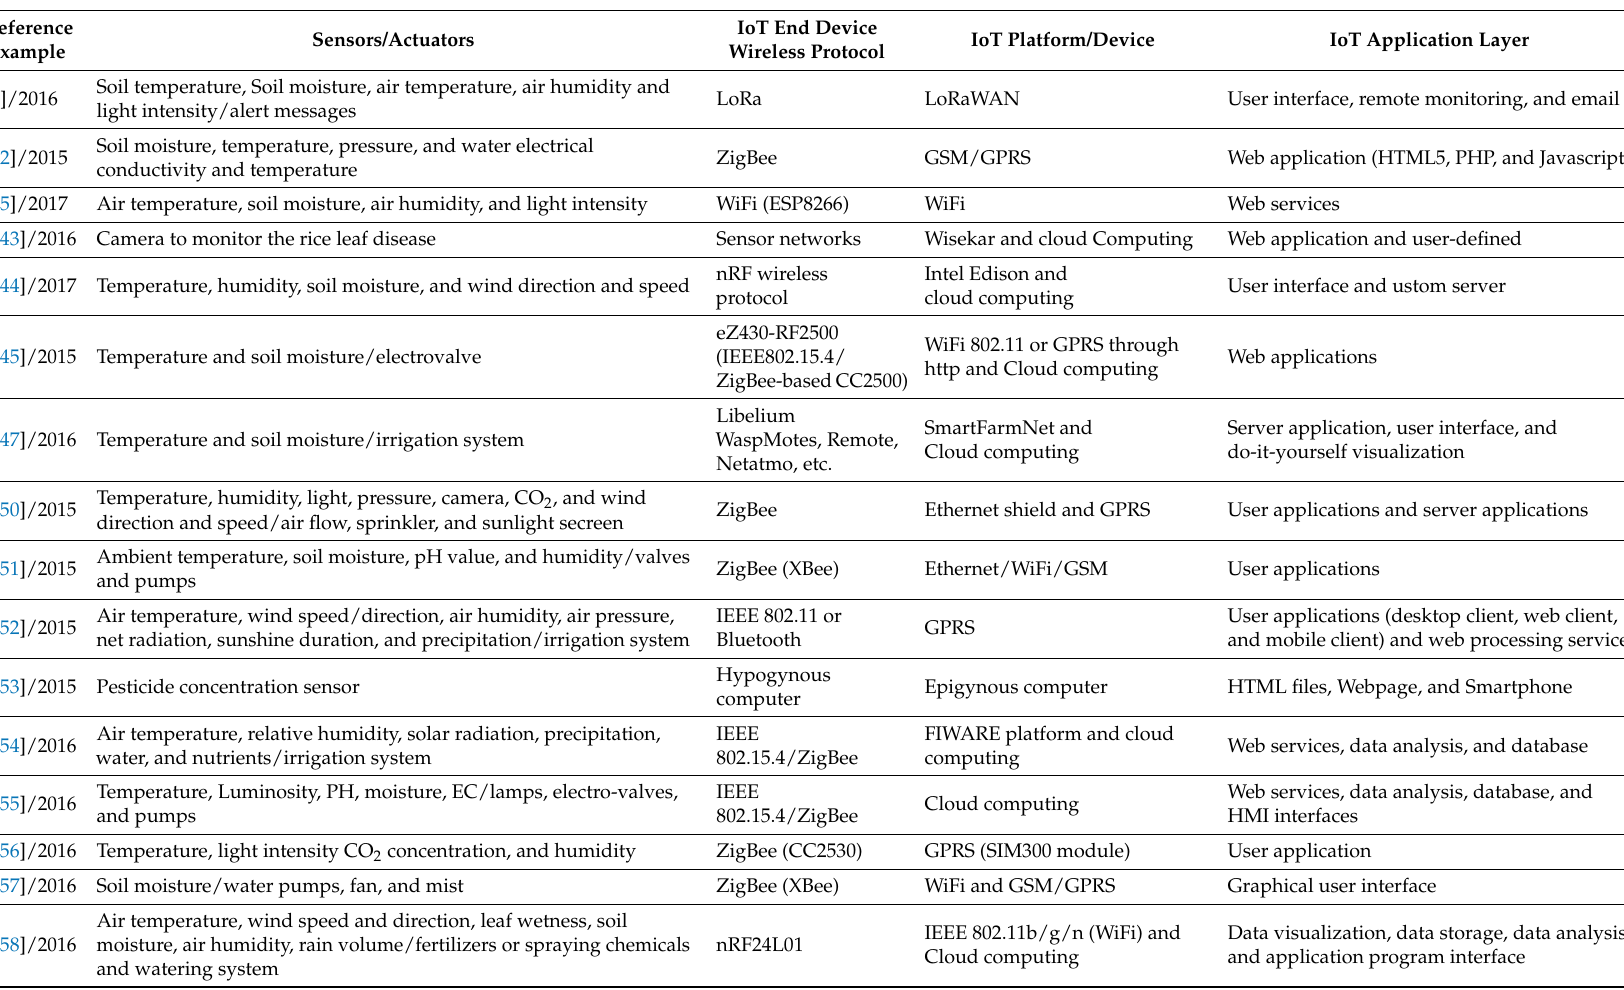
Table 8. Sensors, actuators, and platforms used in agricultural applications based on